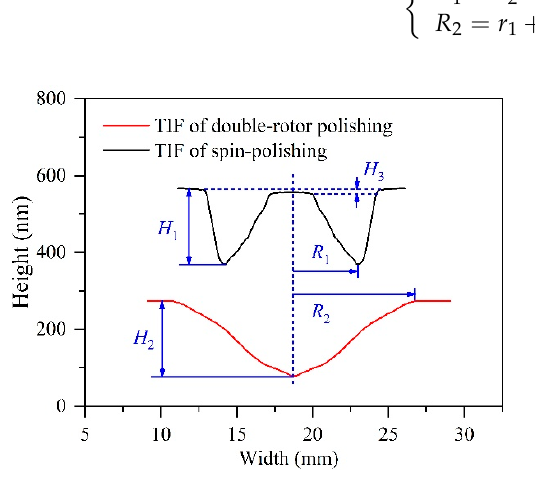
Figure 3. Cross-sectional view of TIF.